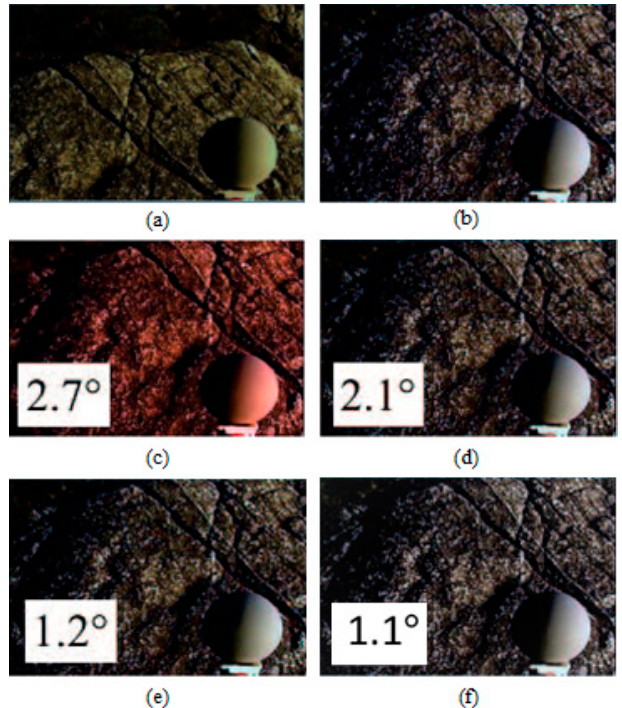
Figure 4. Original, ground truth and its colour-balanced images using different colour correction methods: ( a ) Original image from the Grey Ball dataset [49], ( b ) Ground truth, ( c ) Edge-based-gamut, ( d ) Grey Pixel, ( e ) RCC-Net, ( f ) Proposed CCAFIS’ methods’ images.